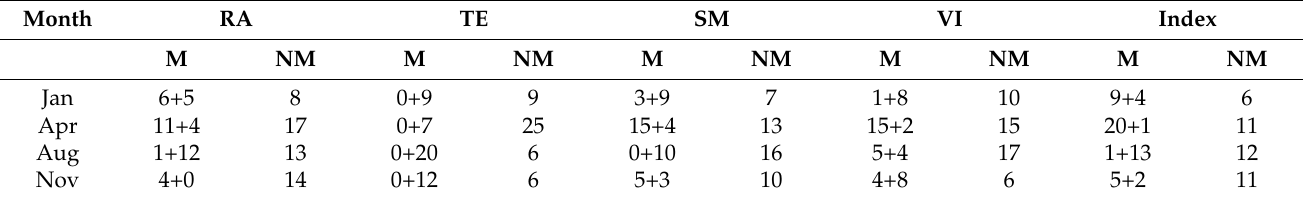
Table 3. Trend matching ( M ) and non-matching (NM) sites of dynamic layers and index with respect to the groundwater level